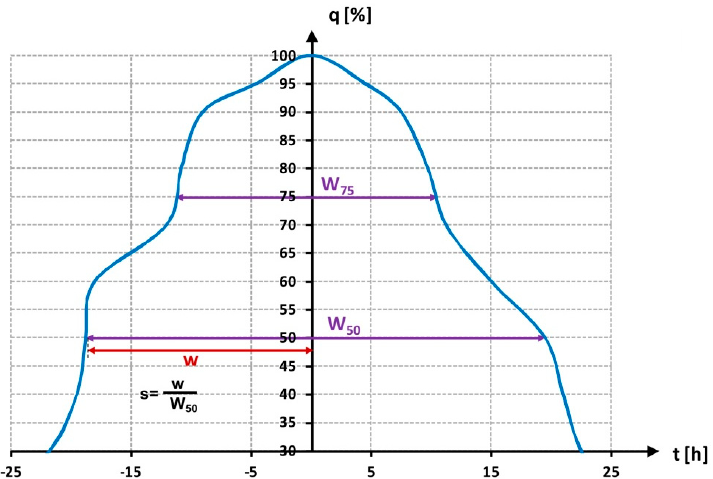
Figure 1. Nonparametric design hydrograph determined with the Archer method (example). W 50 -hydrograph width at 50% of the peak flow; W 75 -hydrograph width at 75% of the peak flow; s - skewness coefficient.